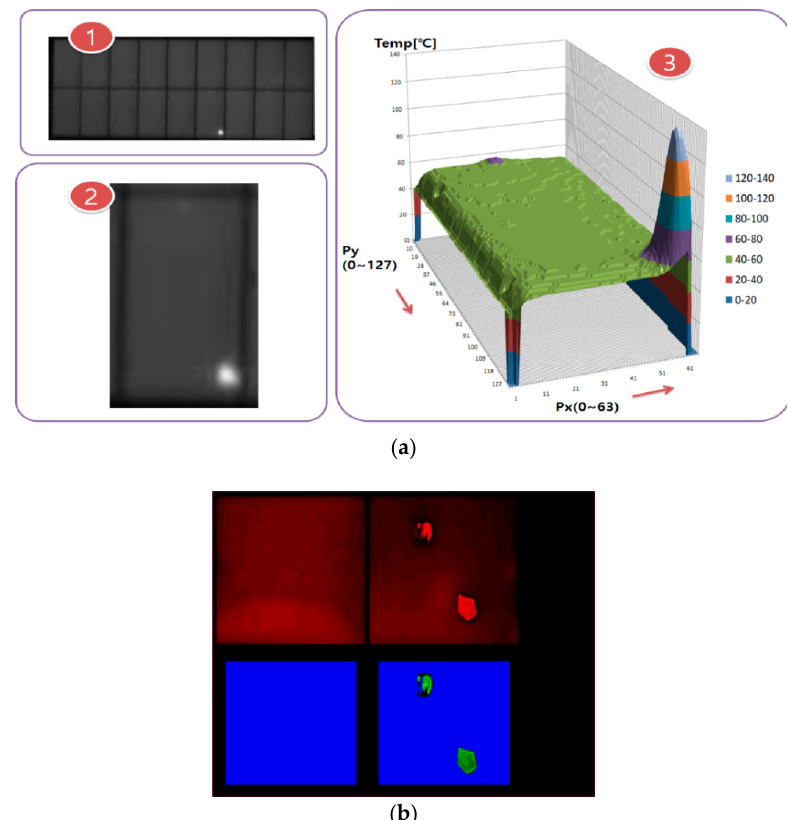
Figure 13. Extracting temperature information and determining the abnormality: ( a ) extracting temperature information; ( b ) normal module and abnormal module judgment.